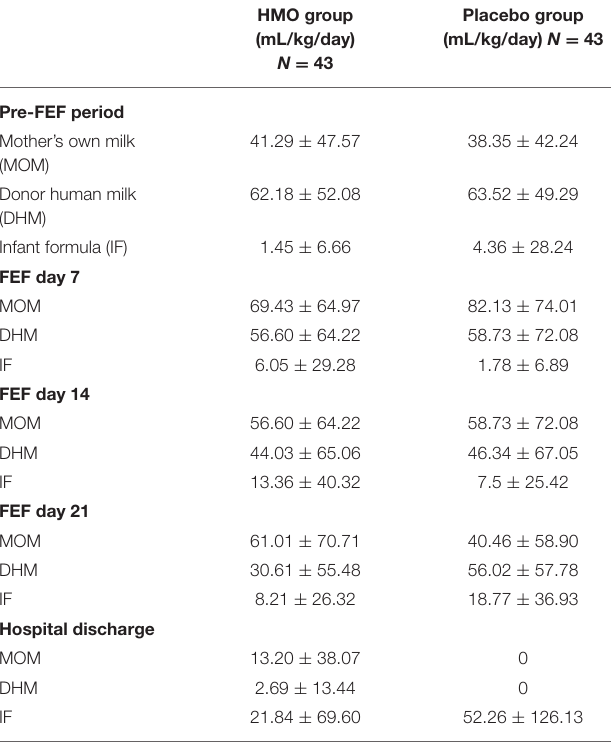
TABLE 2 | Types of milk intake.